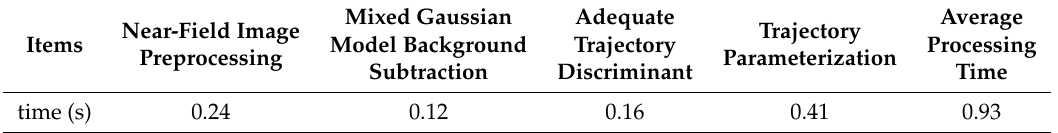
Table 2. The average processing time for each step of the improved NFCV